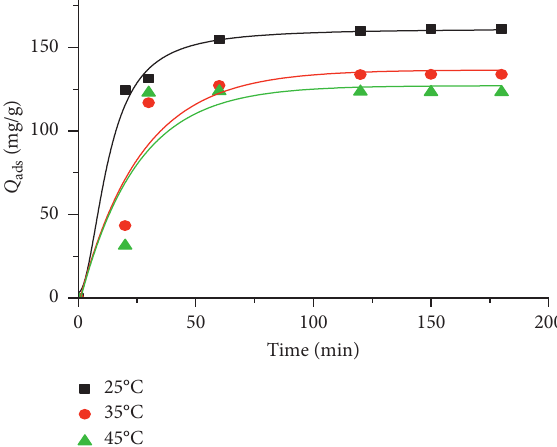
Figure 7: Various adsorption kinetic according to time of three